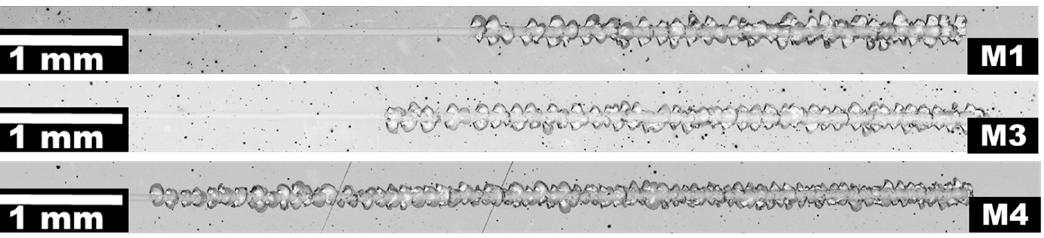
Figure 1. Scratch paths of the M-coatings. In the picture, just final parts of the paths are compared; the paths are incommensurable in this picture. Table 2. Summary of the scratch adhesion values evaluated for the